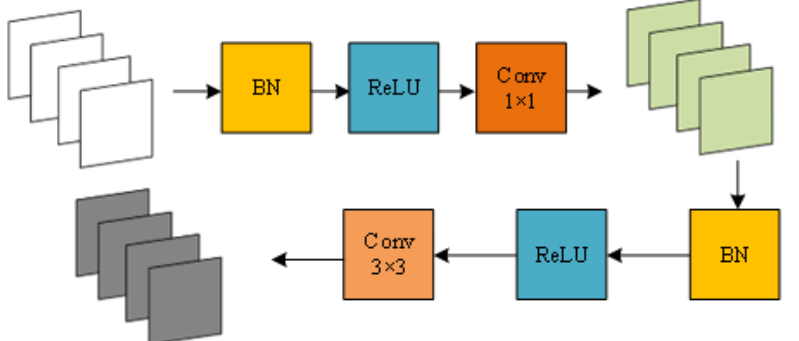
Figure 1. Structure of internal dense modules. BN: batch normalization; ReLU: activation function. Convolution layers are denoted as Conv, including 1 × 1 convolution and 3 × 3 convolution. Generally, to avoid complex calculations, a bottleneck module, that is, a 1 × 1 convolu- tional layer, is added to the dense block to reduce the number of features. Adjacent dense blocks are connected through transition layers to reduce the overall parameter amount of the network and improve computational efficiency. The transition layer consists of con- volutional layers and pooling layers. The transition layer is composed of a convolutional layer and a 2 × 2 AvgPooling layer. The DenseNet network structure is shown in Figure 2.